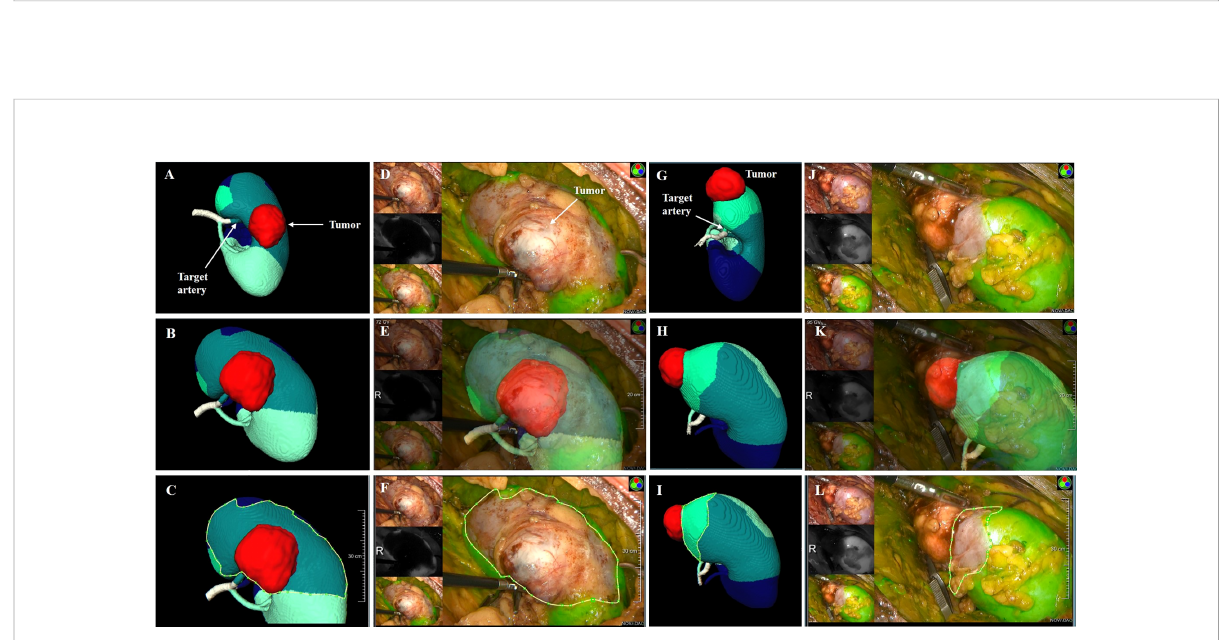
FIGURE 5 the clinical application of TKP model. (A – F) Case 1: a male patient with 3.8 cm tumor on the posterior part of the right kidney. The R.E.N.A.L score is 9. (G – L) Case 2: a female patient with 3.1 cm tumor on the upper polar of the right kidney. The R.E.N.A.L score is 5. (A, G) The TKP model is automatically established based on contrast CT scan and the target segmental artery is determined. (D – F, J – L) ICG is injected immediately after clamping, and the absence of perfusion on the renal parenchyma was con fi rmed with NIRF imaging. ( C vs. F , I vs. L ) The algorithm of dice coef fi cient is applied in assessing the similarity, and the dice coef fi cient is 0.92 and 0.81, which indicates that the ischemic region recorded in NIRF imaging is highly consistent with the perfusion region predicted in the TKP